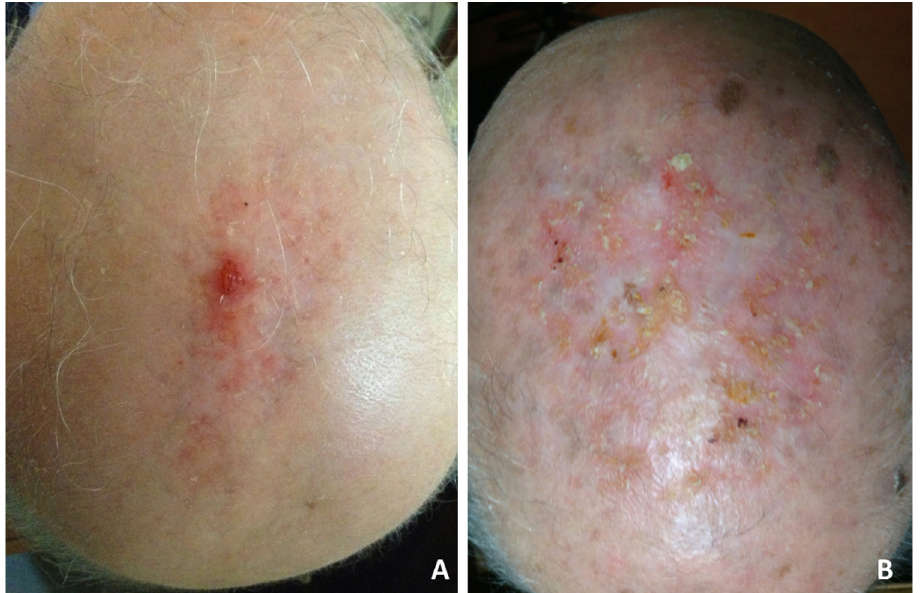
Figure 1. Erosive pustular dermatosis of the scalp; ( A ) solitary eroded and crusting lesions localized on the vertex. Diagnostic consideration was squamous cell carcinoma; ( B ) diffuse scalp involvement of tiny, erythematous, slightly erosive and keratotic papules simulating actinic keratoses.